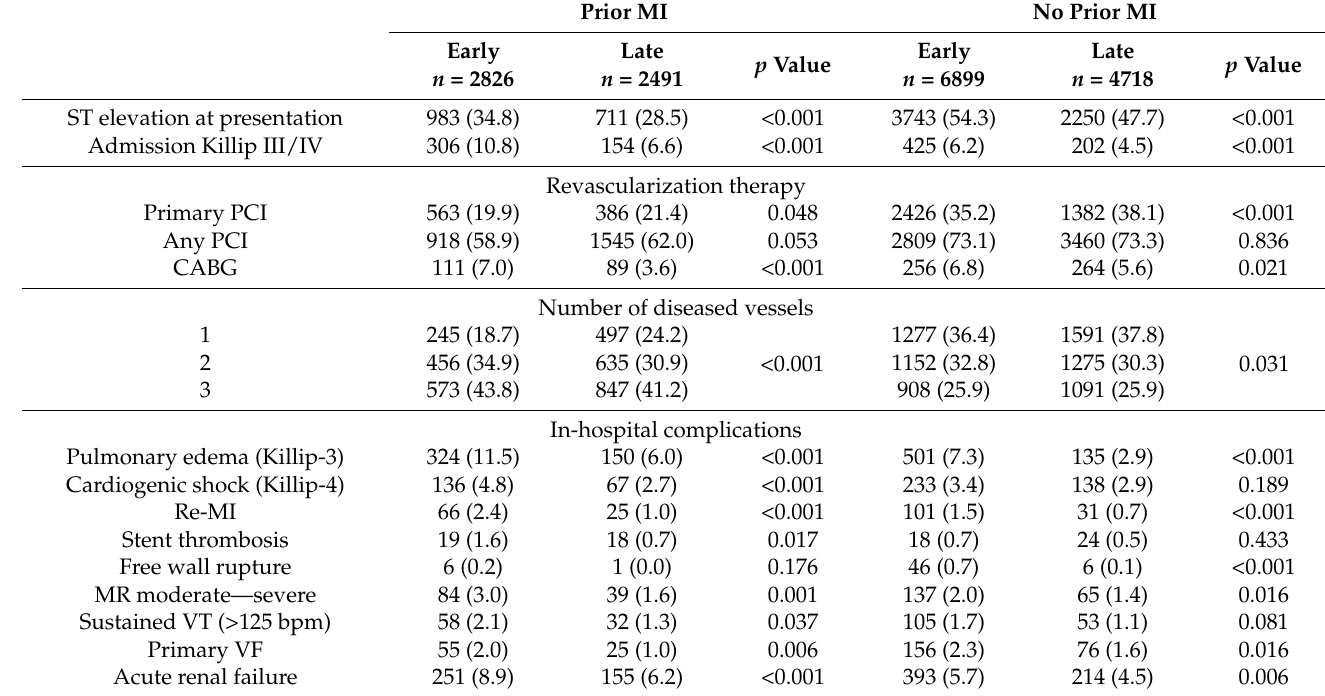
Table 2. Clinical presentation and management of patients with and without prior MI compared between time periods (early 2000–2008 vs. late